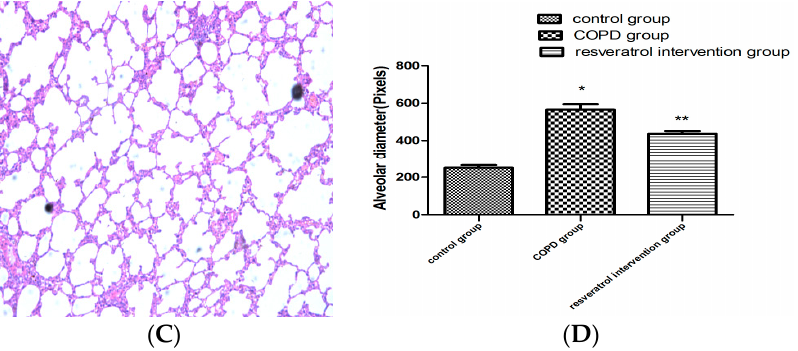
Figure 1. Micrographs of lung histopathology. Histological changes of lung segment stained with HE after resveratrol treatment. ( A ) control group (n = 10): No abnormalities were seen; ( B ) COPD group (n = 10): Pulmonary tissue showed a severe inflammatory response with visible increases in inflammatory cells; ( C ) resveratrol group (n = 10): Inflammation lessened after resveratrol therapy. The number of inflammatory cells decreased. (Magnification, ×200); ( D ) Alveolar diameter was evaluated. Values represent mean ± SEM, * p < 0.01, vs. Control group (n = 10); ** p < 0.01, vs. COPD group (n = 10).